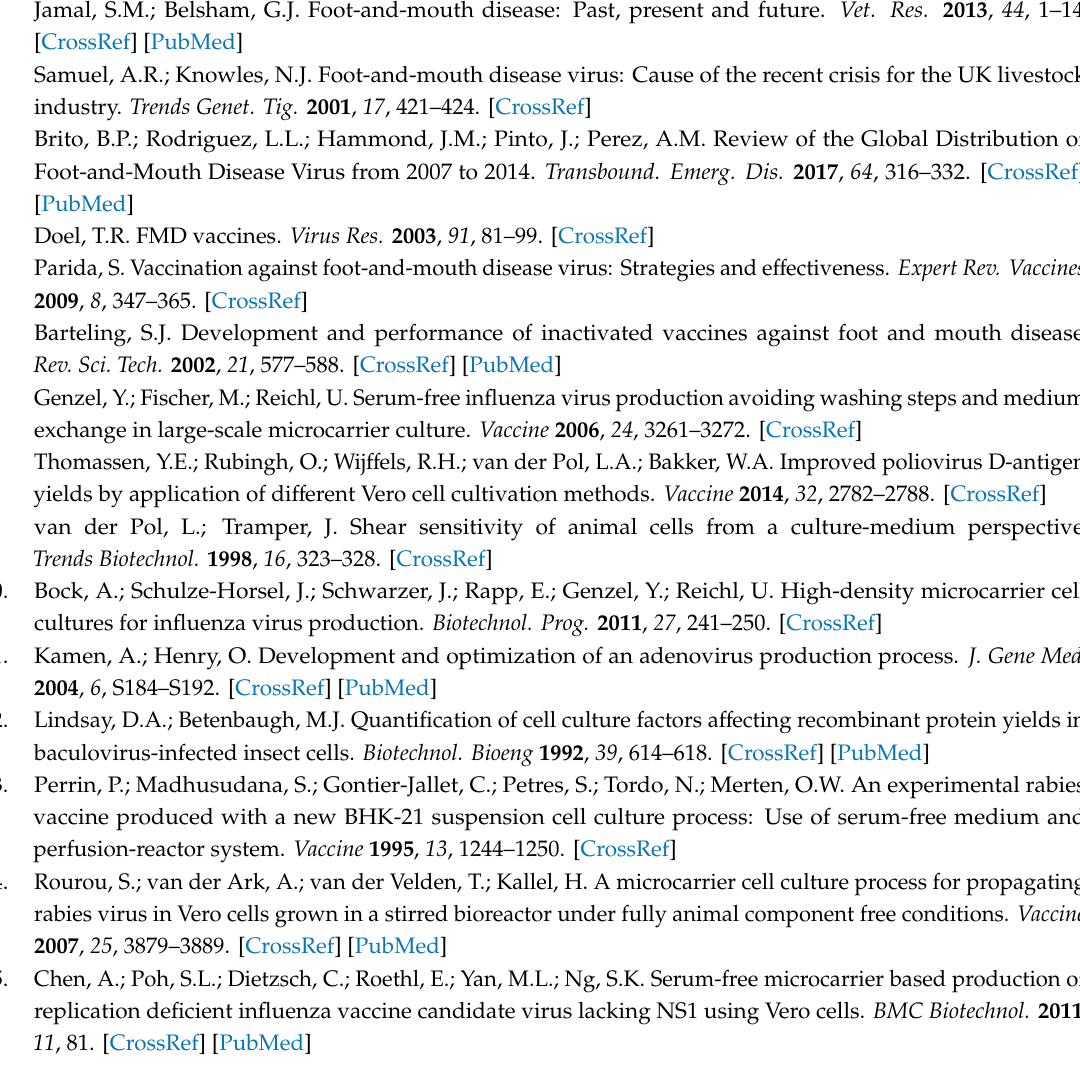
Figure S1: Results of cell culture parameter analysis of cell culture during batch culture propagation; Figure S2: Results of amino acid analysis for cell culture during batch culture propagation.; Figure S3: Cell viability in cell density experiments 20 hpi. Table S1: Overview about the samples used in this study, their origin and passage history, Table S2.1: Statistics and significances for conditioned media testing in BHK300B with a cell density of 1 × 10 6 cells / mL, Table S2.2: Statistics and significances for conditioned media testing in BHK300B with a cell density of 3 × 10 6 cells /